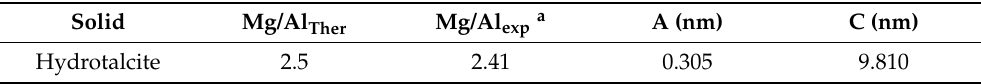
Table 1. Compositional and structural properties determined for HT-DSC [31]. Solid Mg/Al Ther Mg/Al exp a A (nm) C (nm) Hydrotalcite 2.5 2.41 0.305